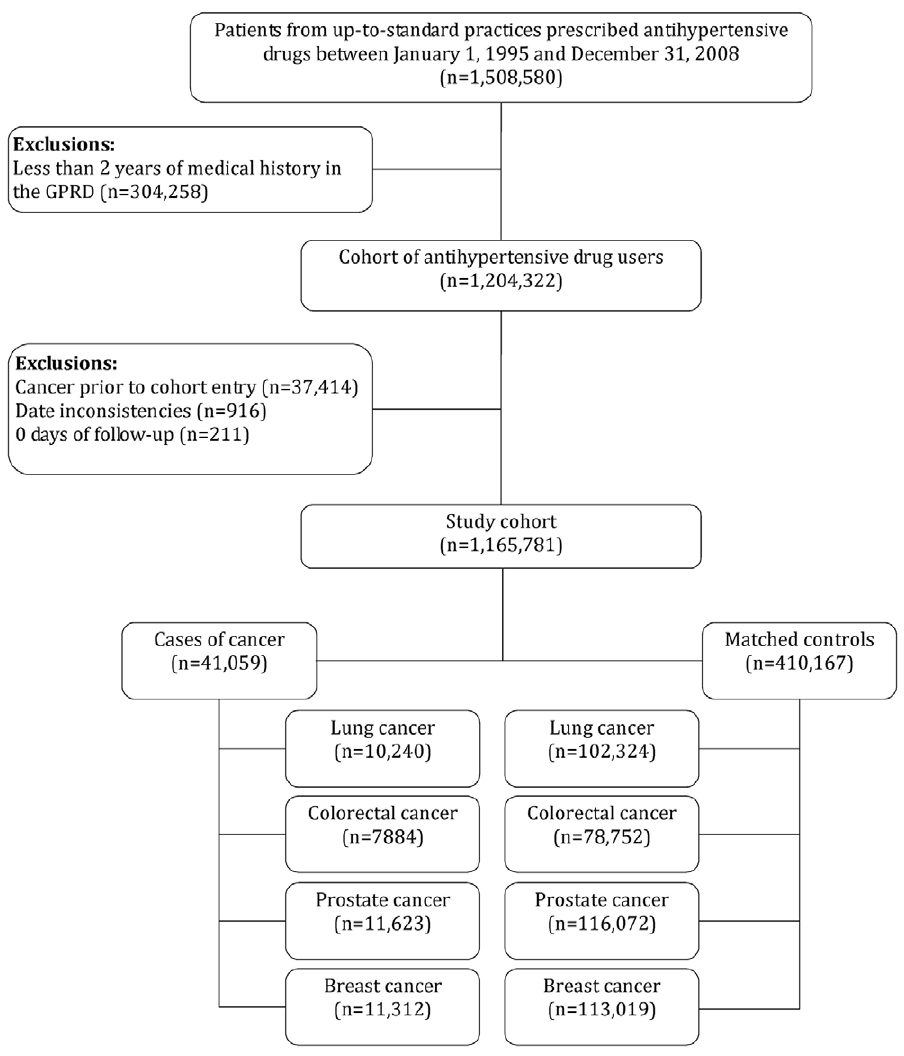
Figure 1. Study flow chart.